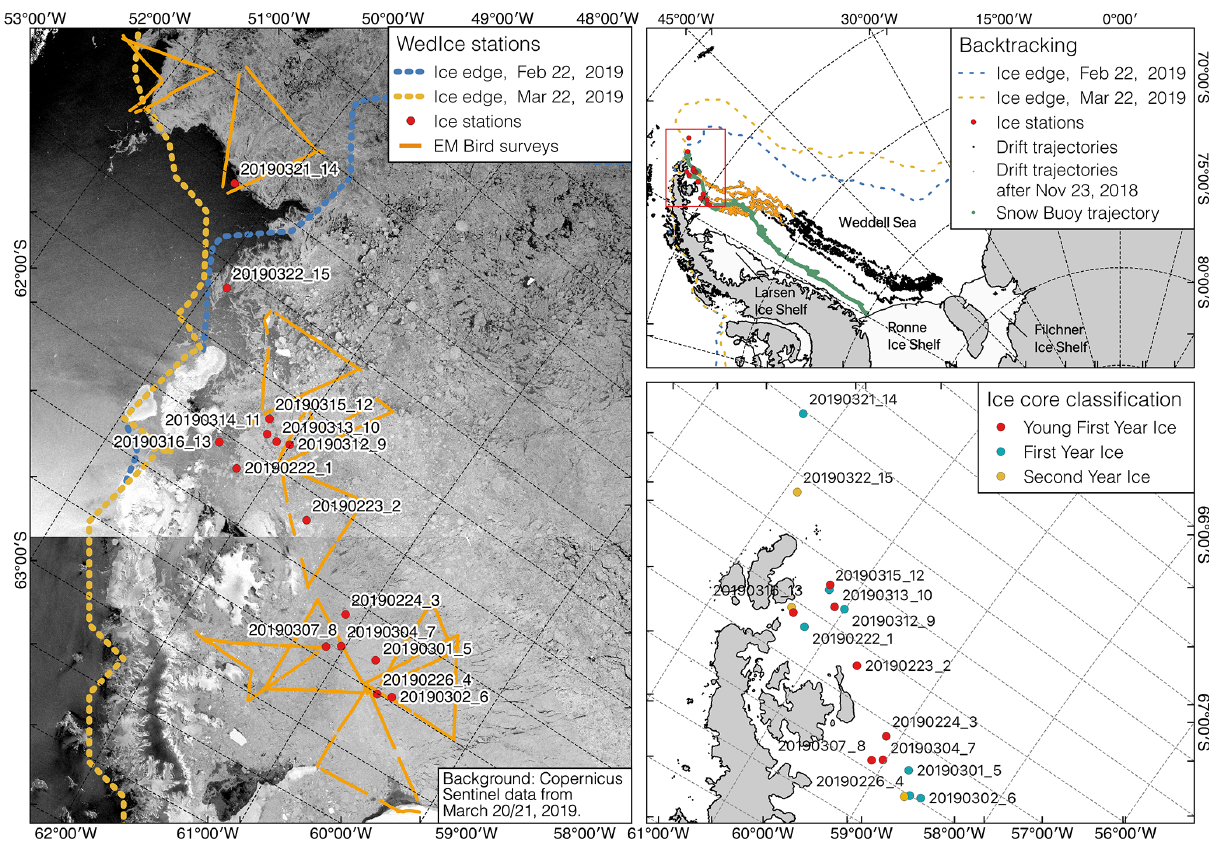
Figure 1. Left: overview map of all sampled ice stations (red dots) and helicopter-borne electromagnetic (HEM) induction sounding surveys (yellow lines). The ice station names are composed of the respective date and a consecutive station number. The dashed lines indicate the ice edge on the first day (22 February 2019, blue) and last day (22 March 2019, yellow) of our study. Background: Copernicus Sentinel-1 synthetic-aperture radar (SAR) images from 20 and 21 March 2019. Upper right: back trajectories (black dots) of the sampled ice stations (red dots) during WedIce. The green line denotes the drift trajectory of Snow Buoy 2018S59 deployed in February 2018 off the Ronne Ice Shelf. Lower right: ice age classification of all sampled ice cores – second-year ice (yellow), first-year ice (blue), young first-year ice